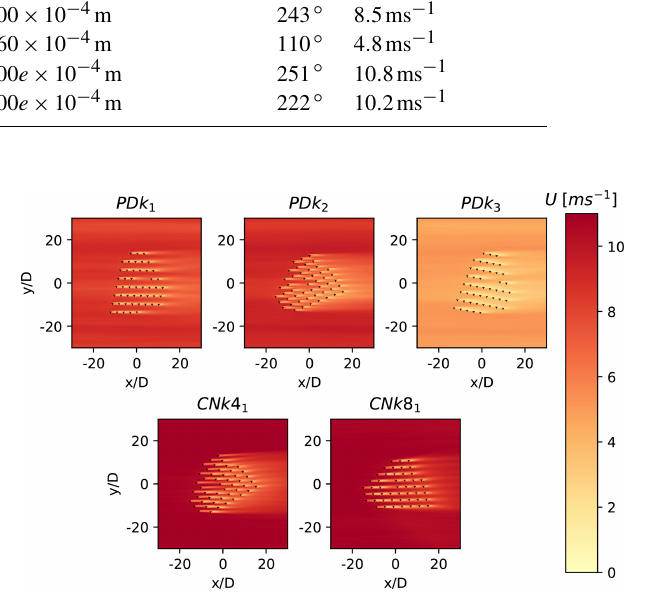
Figure 10. Time-averaged stream-wise hub height velocity for all selected cases. Different wind directions are realized by rotating the entire wind farm in the simulation domain and feeding the inflow velocity in the horizontal- x